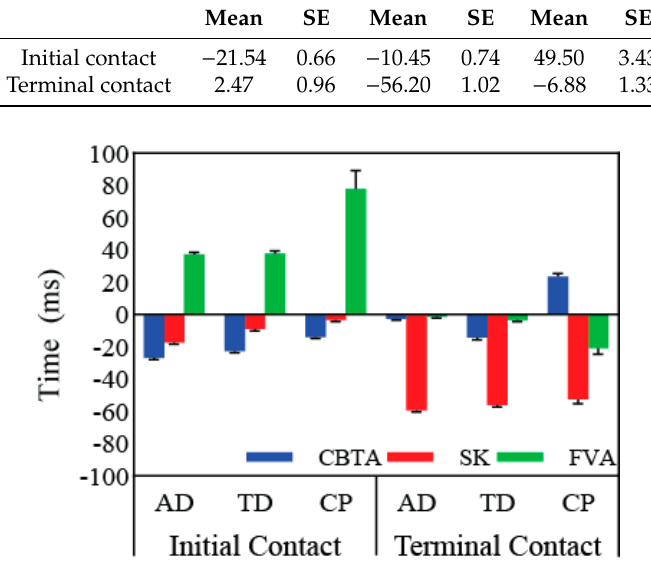
Figure 2. Initial and terminal contact time difference (mean ± SE) of kinematic versus kinetic gait event detection methods (GEDM) for each group. Positive values indicate a delay in event detection while negative values indicate premature detection of the kinematic GEDM. CBTA: coordinate-based treadmill algorithm; SK: shank angular velocity algorithm; FVA: foot vertical acceleration algorithm; AD: adult; TD: typically developing children; CP: children with cerebral palsy.